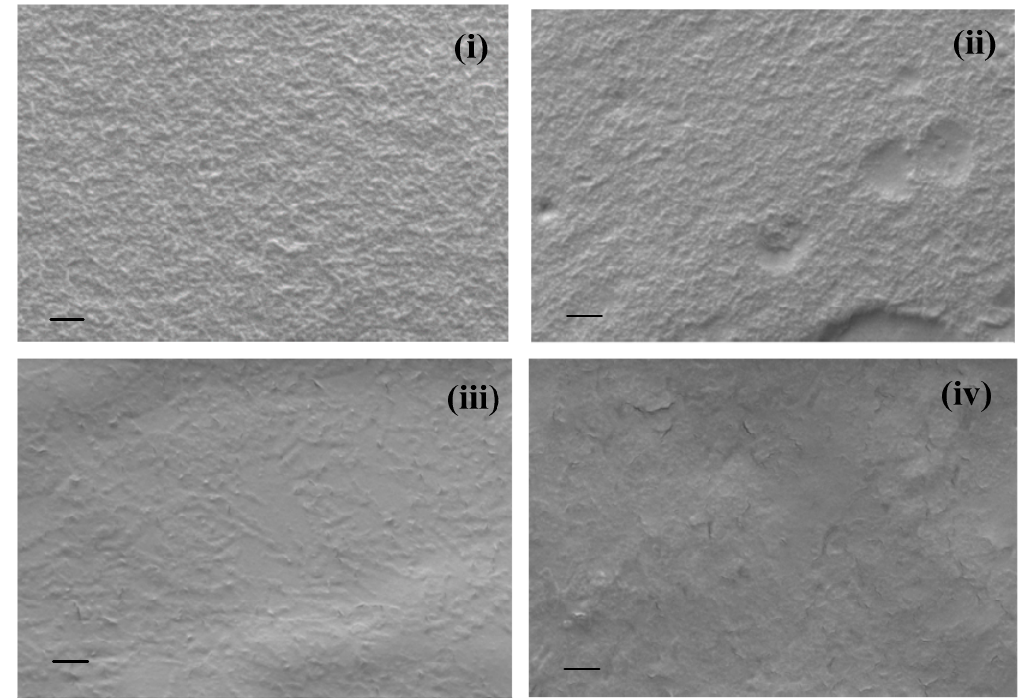
Figure 5. Scanning electron microscopy (SEM) images taken at scale bar = 200 nm on ( i ) NRL film (control), and composite films made of NRL and NOCNF with varying concentration of NOCNF ( ii ) 0.1 wt.%, ( iii ) 0.2 wt.%, ( iv ) 0.4 wt.%. Red circles indicate the cracks in the film.